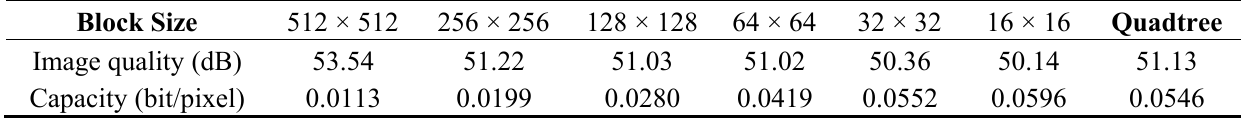
Table 1. Comparisons of test image Lena with conventional scheme.